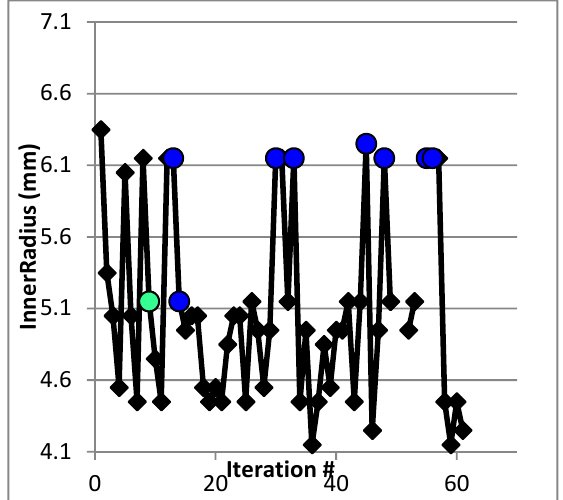
Figure 21. Inner radius values vs. iteration number for the second model.